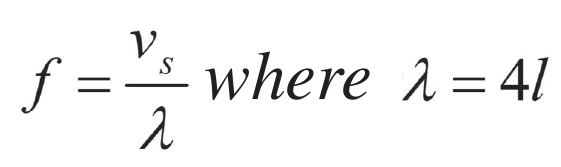
, sound velocity; l, length of s